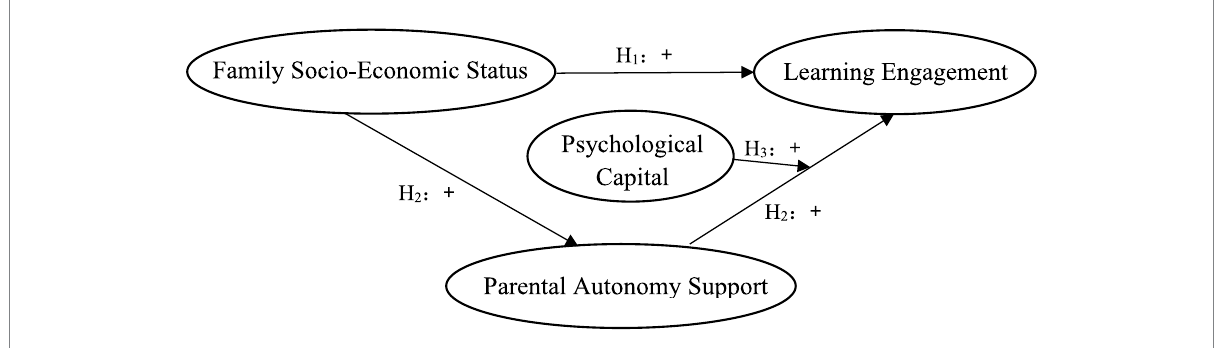
FIGURE 1 Family SES, learning engagement, parental autonomy support and psychological capital relationship hypothesis model diagram. H 1-3 represents hypothesis 1–3 respectively, and the symbol represents the direction of